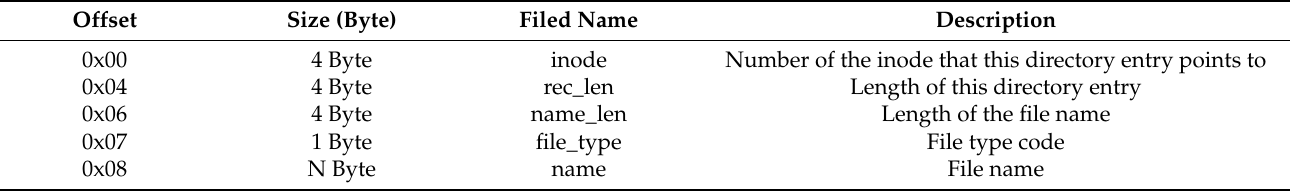
Table 2. Main structure of directory entries related to file